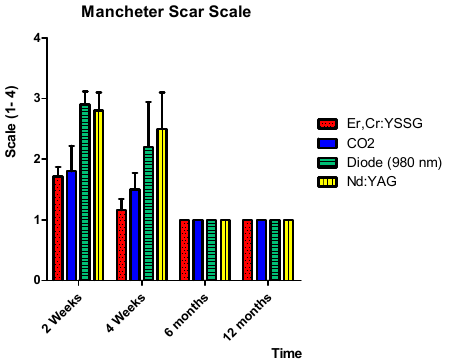
Figure 9. Global mean values of the Manchester scar scale for the different laser wavelengths and at different follow-ups .